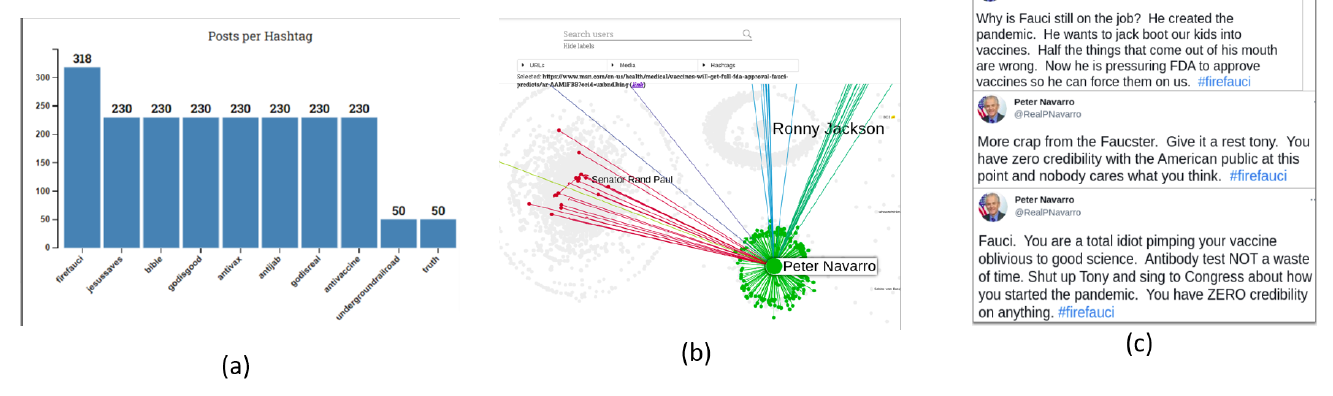
Figure 7. Results of Fauci use-case analysis: ( a ) hashtag plots of Community 14 , ( b ) an example of MSN article spread, and ( c ) Peter Navarro’s tweets against